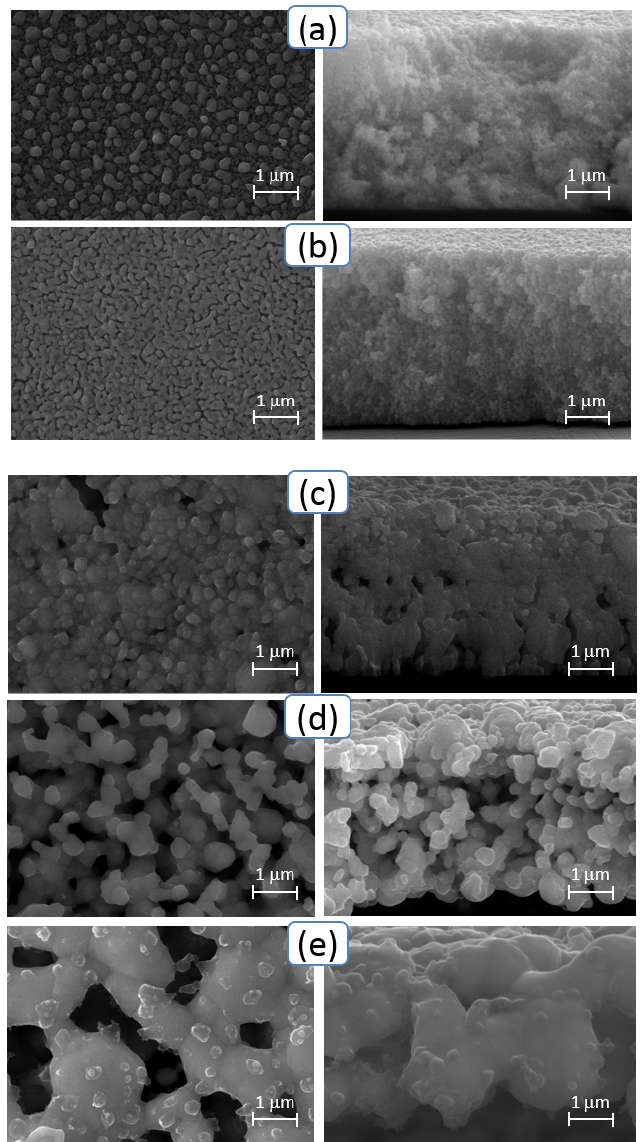
Figure 4. SEM images of the surface (left) and the cleavage (right) for the printed electrodes on Si samples obtained at the annealing temperatures of 100 °C ( a ), 200 °C ( b ), 300 °C ( c ), 400 °C ( d ), and 500 °C ( e ).